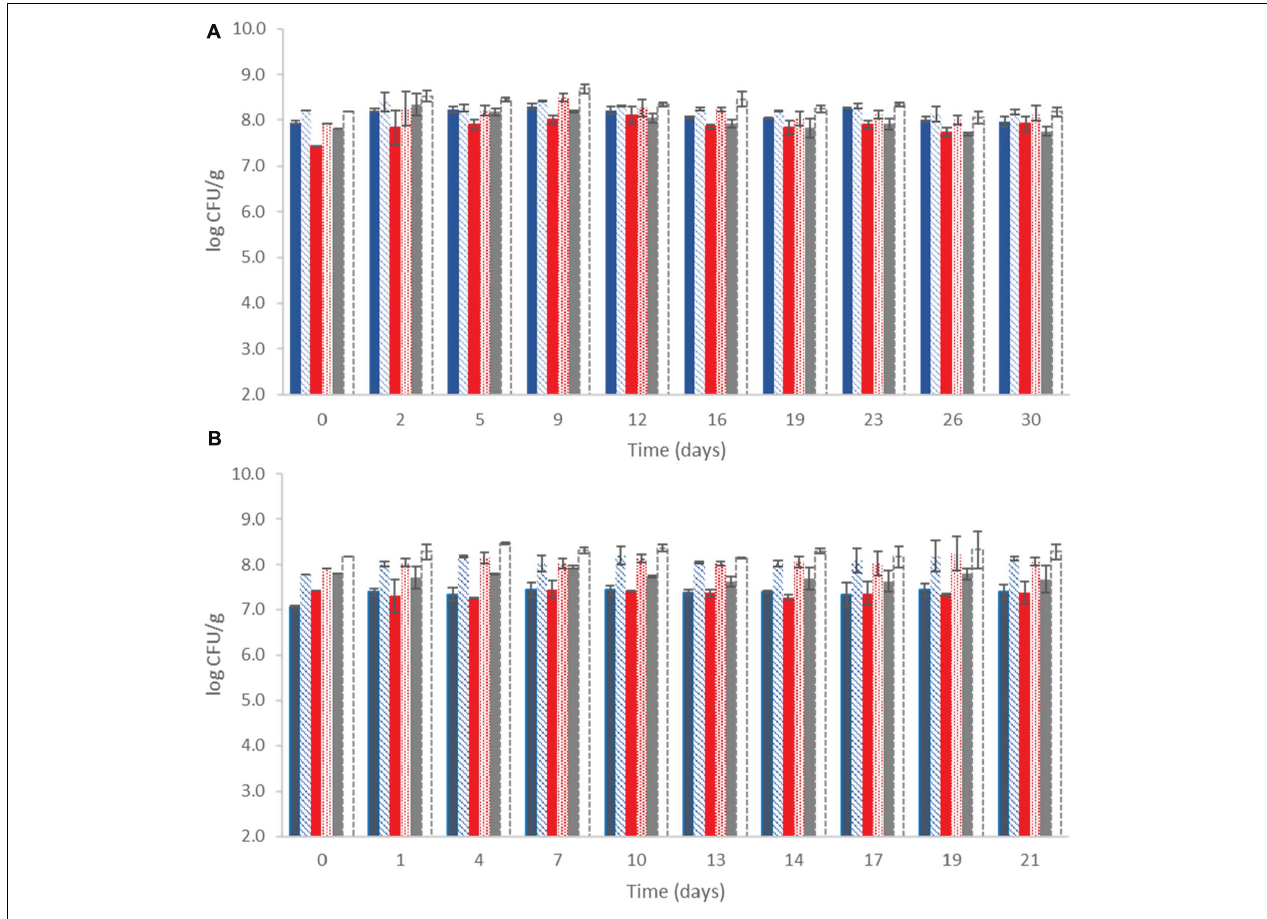
FIGURE 1 | Population of total viable counts ( (cid:4) ), LAB ( (cid:4) ), and lactic cocci/streptococci ( (cid:4) ) at control samples and Population of total viable counts ( ), LAB ( ), and lactic cocci/streptococci ( (cid:3) ) at probiotic samples, during storage of yogurt at 4 ◦ C (A) and at 12 ◦ C (B) . Bars represent mean values ± standard deviations. No statistical differences ( P > 0.05) were observed for all cases except from LAB between probiotic and control samples ( P < 0.05) at both temperatures during